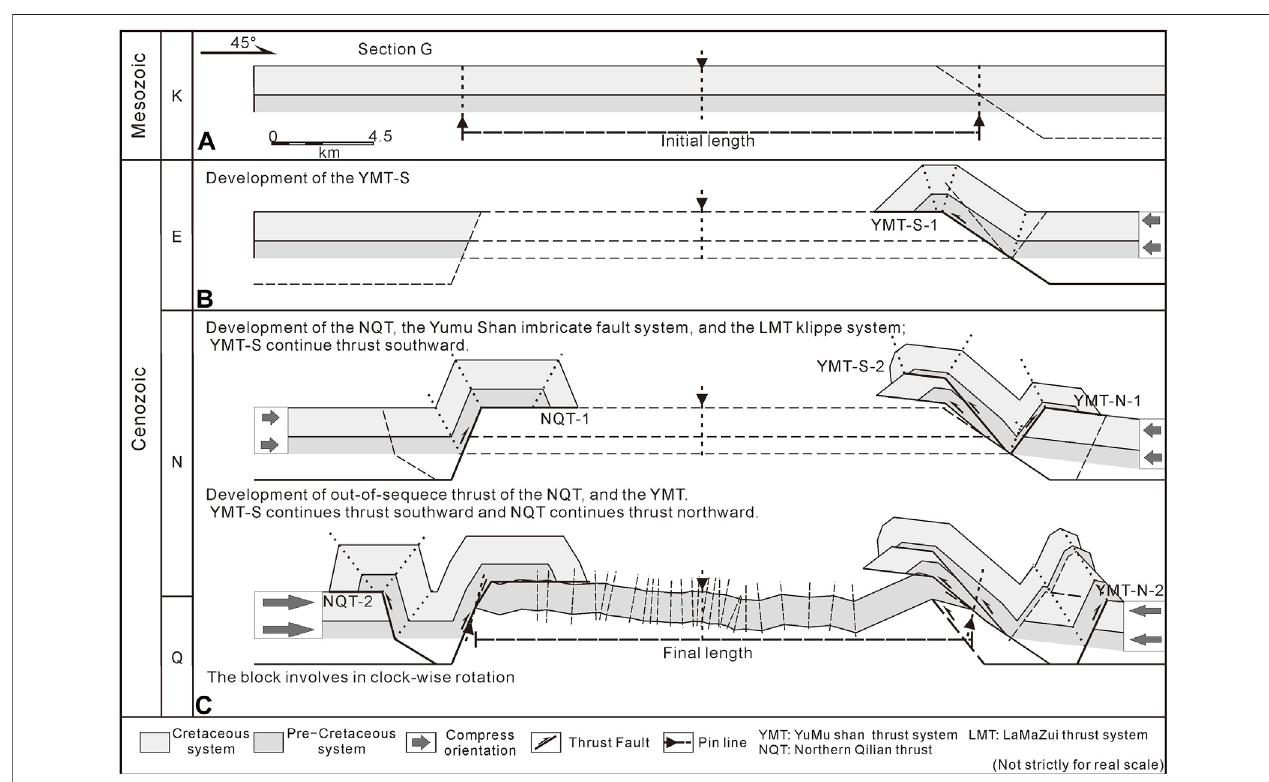
FIGURE10| Modelofthefaultsystemdevelopmentinthestudyarea. (A – C) Faultpropagationandstratadeformationprocess. (A) Therestoredinitiallengthofthe Cretaceousstrataisshown(based onthestratadataofthisstudy); (C) The fi nallengthoftheCretaceousstrataofthissection.Eachofthedottedlinesrepresent thefold hinge,basedonthe fi eldworkofthisstudyandthethicknessofthestrataisbasedontheBureauofMineralResourcesofGansuProvince(BMRGP,RegionalGeological Survey) (1982).